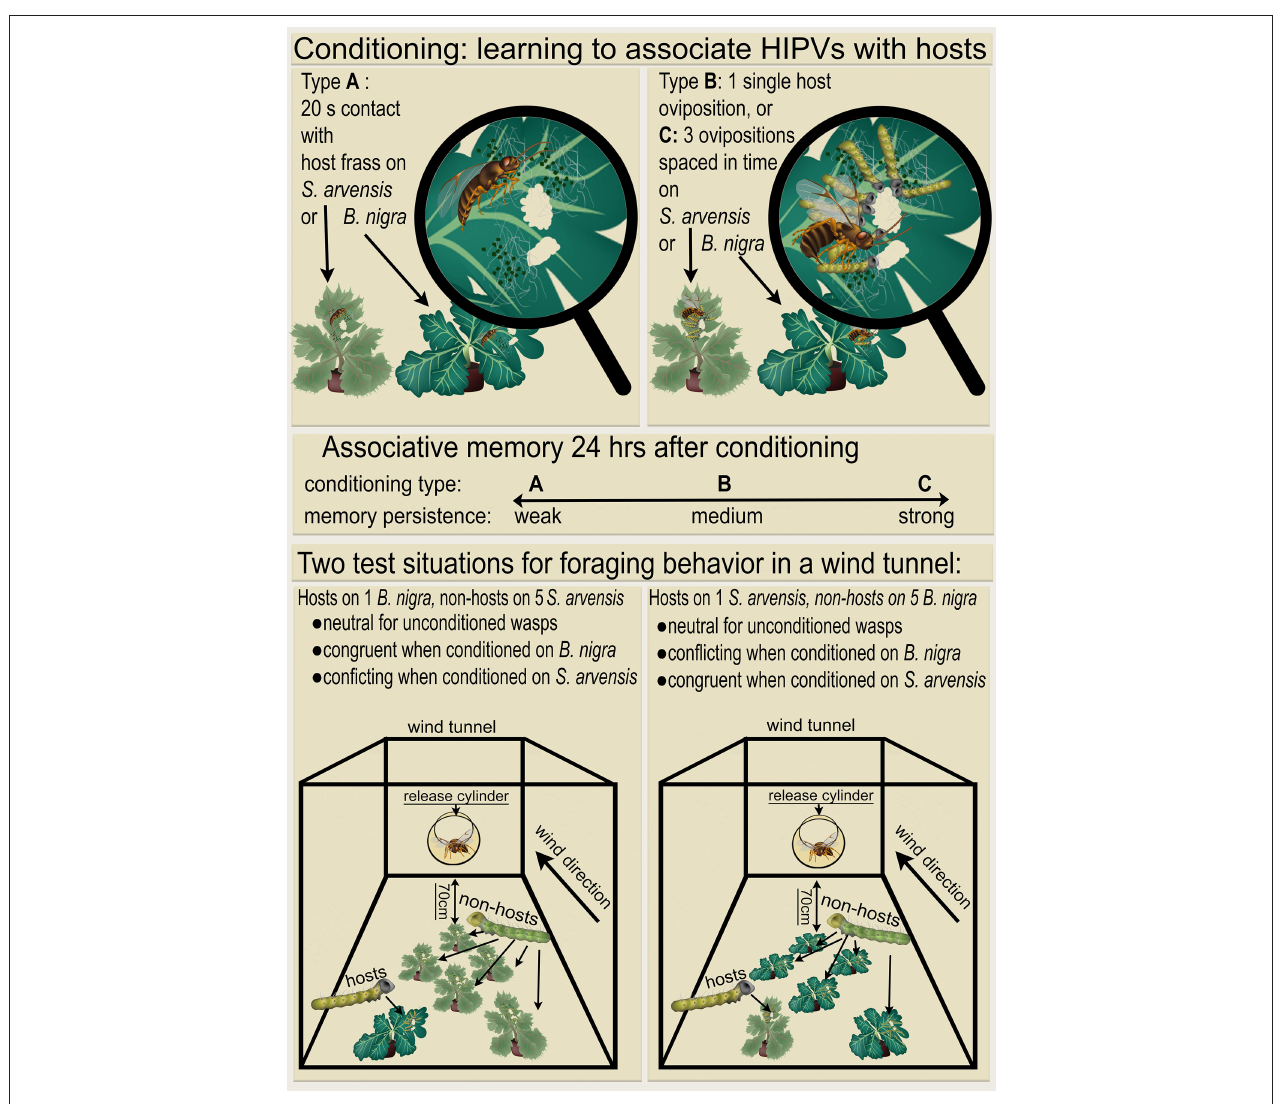
FIGURE 1 | Overview of the conditioning and test procedures. Wasps were given a learning experience (Top) , in which they learned to associate herbivore-induced plant volatiles (HIPVs) of Brassicae nigra (dark green plants) or Sinapis arvensis (light green plants) with either a 20s host-frass ( Pieris brassicae ) exposure, 1 single host oviposition, or 3 host ovipositions spaced in time. These conditioning treatments resulted in increasing levels of memory persistence ( mid panel , indicated with weak, medium or strong), for either B. nigra or S. arvensis as predictor for the presence of P. brassicae hosts. The next day these conditioned wasps were tested in foraging situations created in a wind tunnel (Bottom) , which were either congruent or conflicting with their memory. A conflicting situation consisted of non-hosts ( Mamestra brassicae ) on five of the plant of the species on which the wasps previously experienced hosts or host-frass, and hosts on only one plant of the alternative plant species, located most upwind from the release point. The congruent situation had the same array of 5 plants with non-hosts and one plant with hosts, but in this case the hosts were present on the same plant species on which the previously were conditioned. Unconditioned wasps were also tested, for which both foraging situations were considered as neutral. Altogether, this results in 14 different